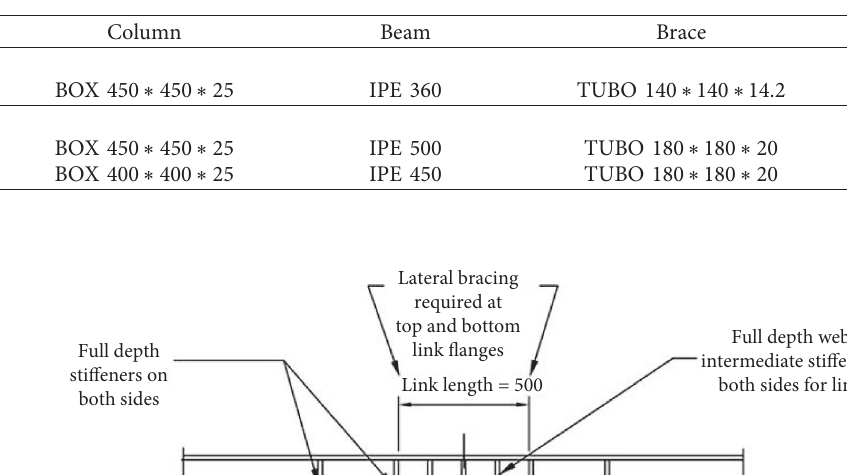
Figure 13: Overview of a simple structural frame model with an eccentric bracing system. Table 7: Sections obtained for different structural members in frames with an eccentric bracing system.